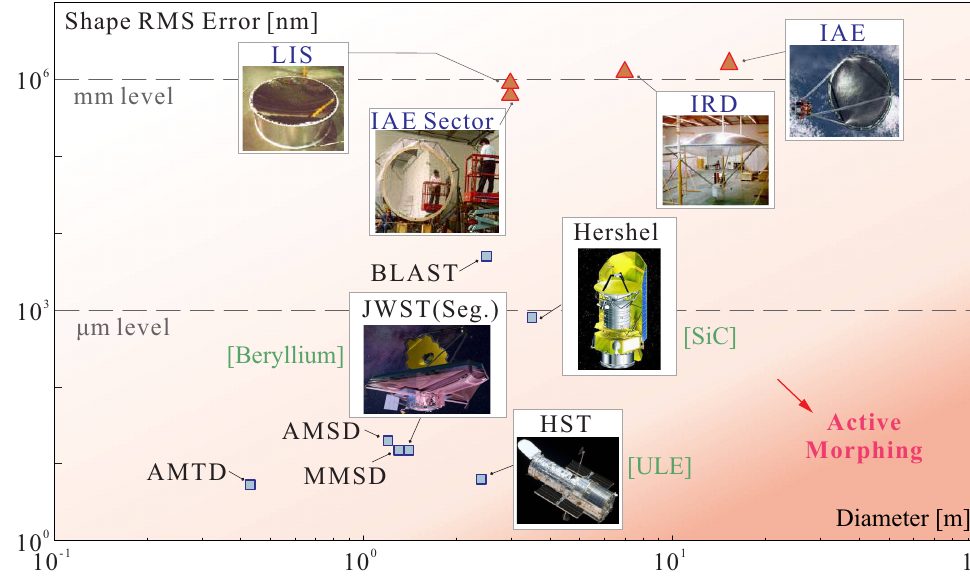
Figure 3. Literature survey of the shape accuracy with respect to the reflector size for various projects (data collected from [12,13], image credits: L’Garde Inc. and